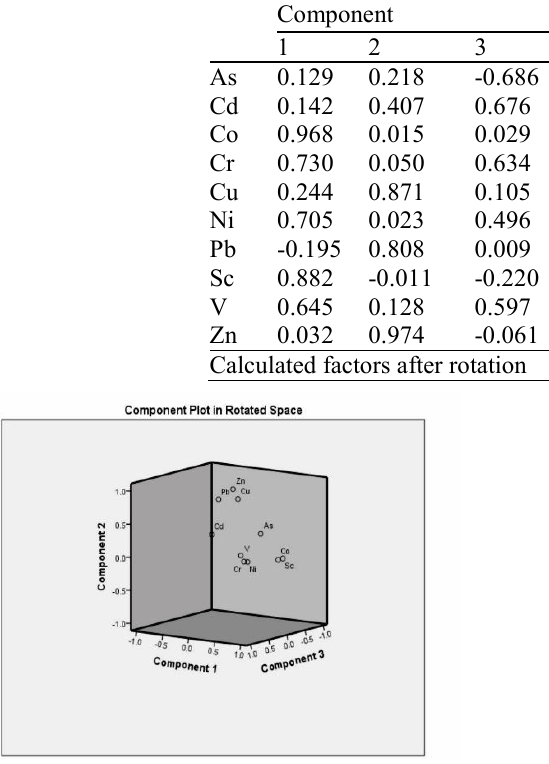
Fig. 2. Plot bar of effective components on